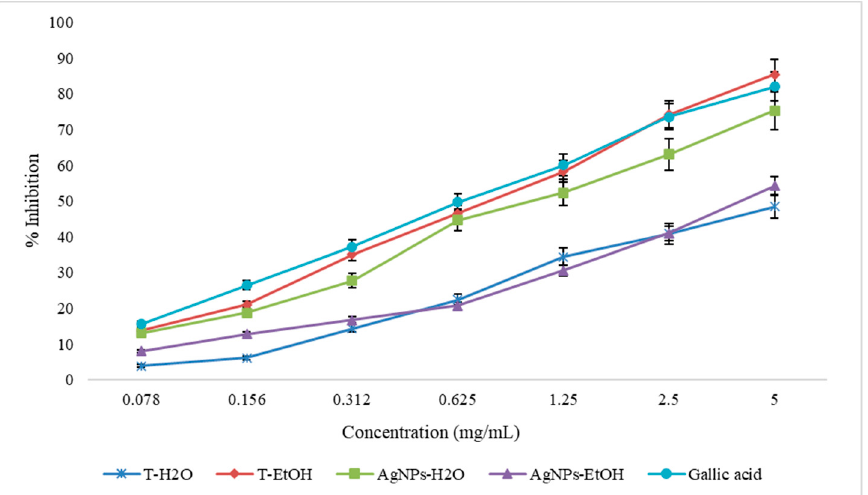
Figure 15. Graphical representation of the erythrocyte hemolysis inhibition capacity (%) of extracts and of their corresponding AgNPs solutions, compared to gallic acid.